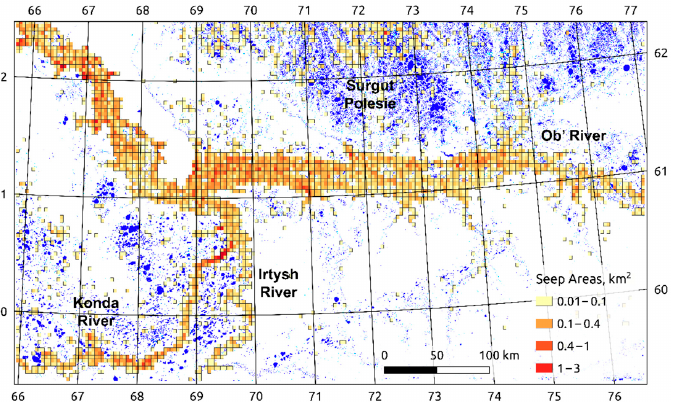
Figure 4. Gridded map (3 × 3 km 2 ) of seep areas within the studied region: most seep areas cover the wide floodplains of Ob’, Irtysh, and Konda rivers. Most watershed contains only minor seep areas except huge bog complexes which could result from the misclassification of lakeshores. However, some traces of CH 4 seeping were actually found within Surgut Polesie—one of the largest bog-lake areas in the world (blue—lake areas, orange—seep areas).